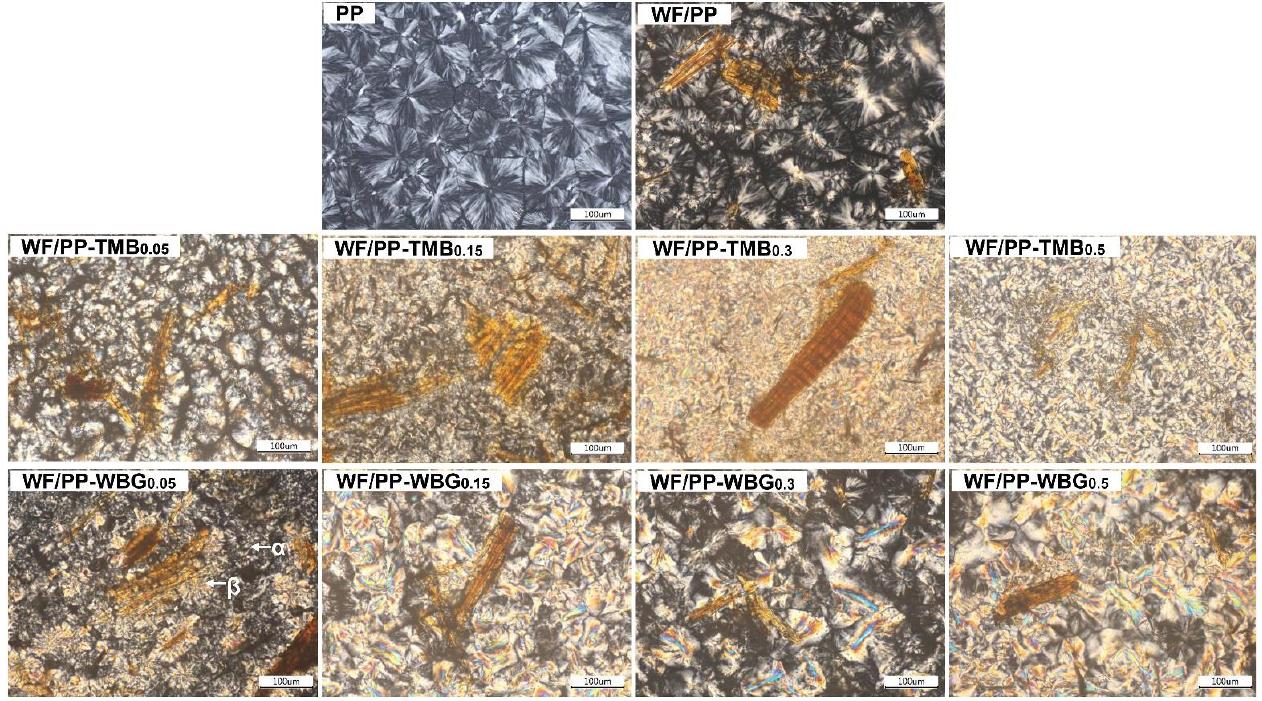
Figure 4. Polarized optical micrographs of pure PP, WF/PP, WF/PP/TMB, and WF/PP/WBG containing varying concentrations of TMB5 or WBG II after non-isothermal crystallization at cooling rate of 5 °C/min.